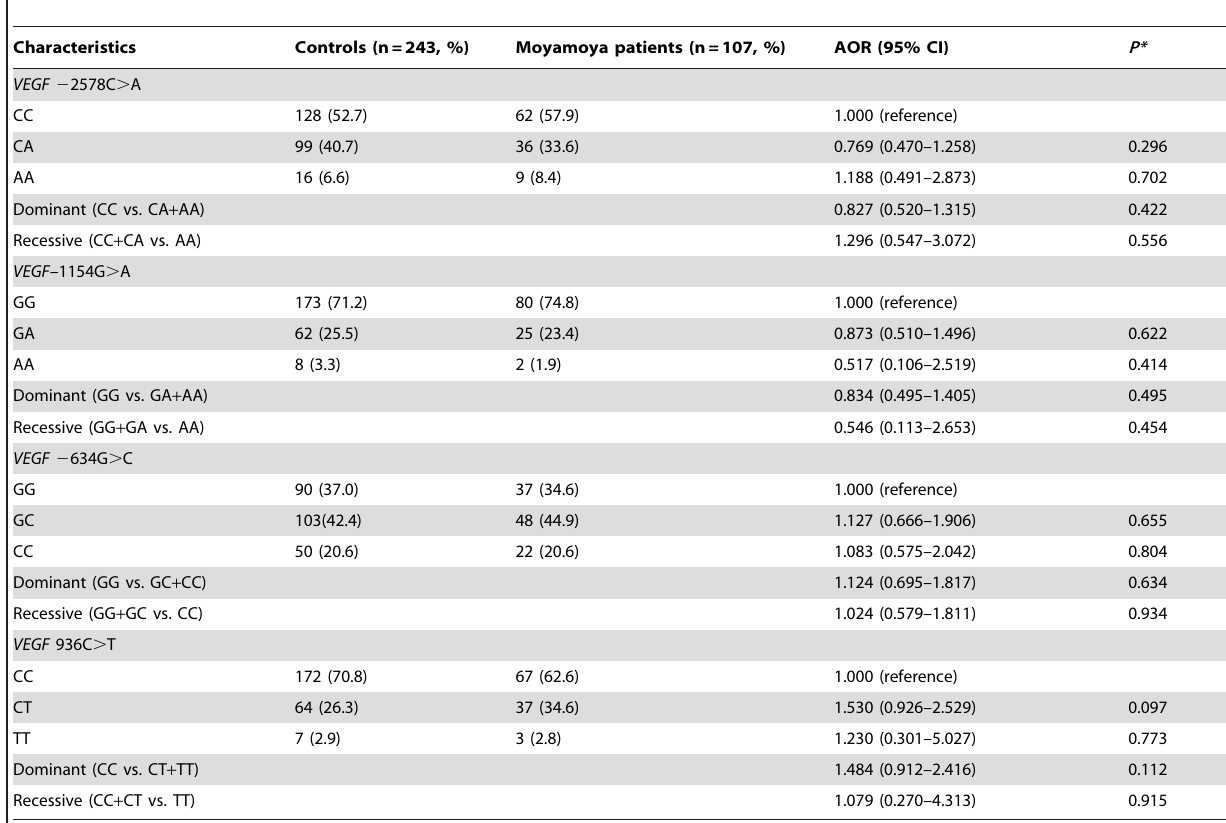
Table 2. The frequencies of the VEGF 2 2578C . A, 2 1154G . A, 2 634G . C, and 936C . T polymorphisms between control subjects and patients with moyamoya